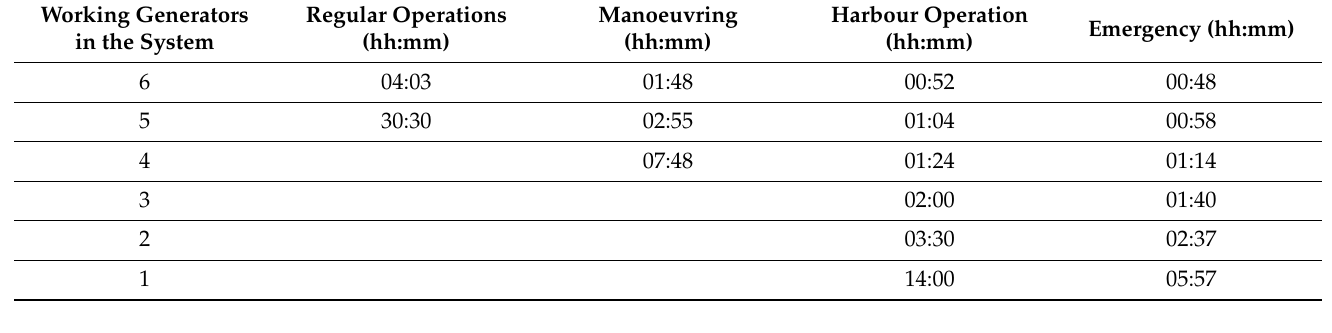
Table 3. Estimated charging time of the onboard battery banks.